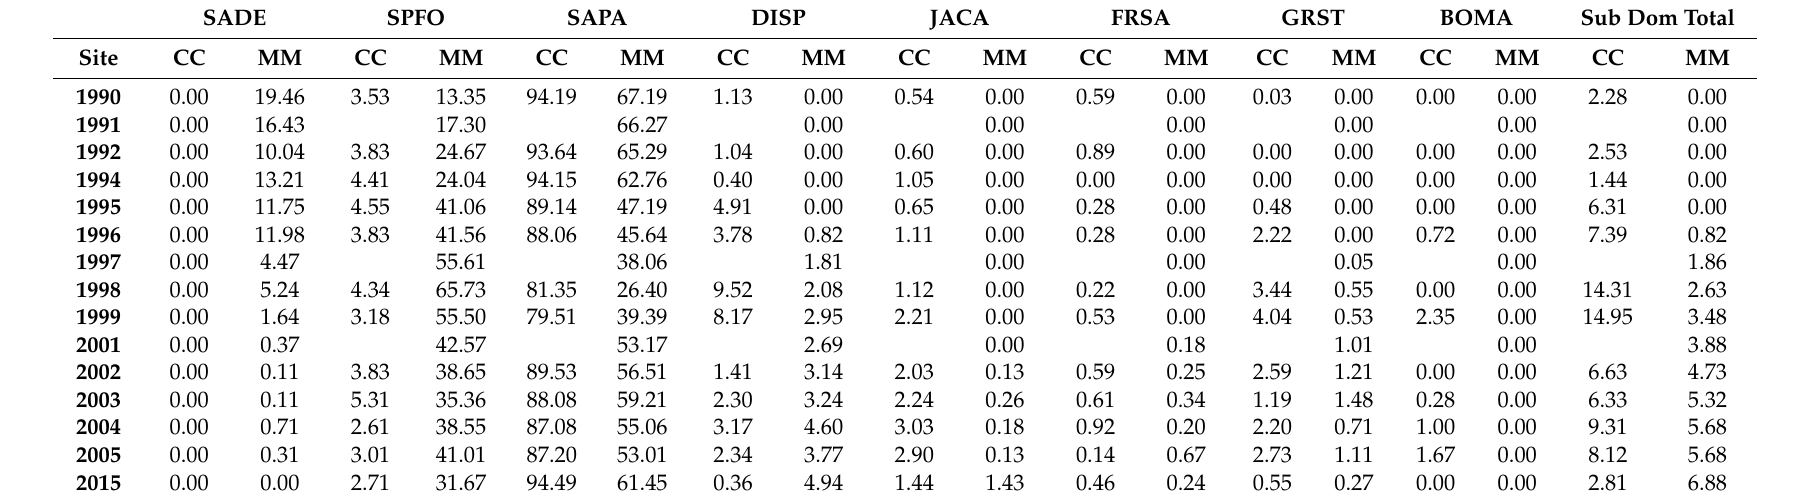
Table A1. Species cover over the study period. Values below reflect the total percent cover for each species over the entire study area for each year, and thus may not be equivalent to the percentages reported in the results, which reflect mean density per plot. Species abbreviations are as follows: SADE = Salicornia depressa , SPFO = Spartina foliosa , SAPA = Salicornia pacifica, DISP = Distichlis spicata, JACA = Jaumea carnosa, FRSA = Frankenia salina, GRST = Grindelia stricta, BOMA